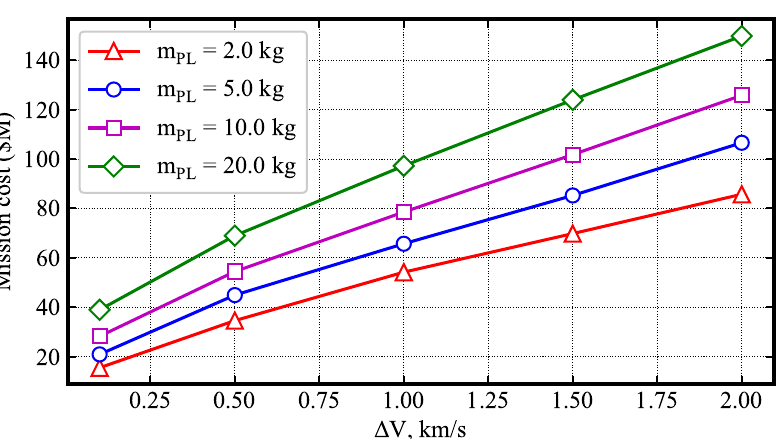
Figure 32. Mission cost as a function of ∆ V for a chemical propulsion system. m PL refers to the science payload (instrument mass). Derived using data from Edwards et al.